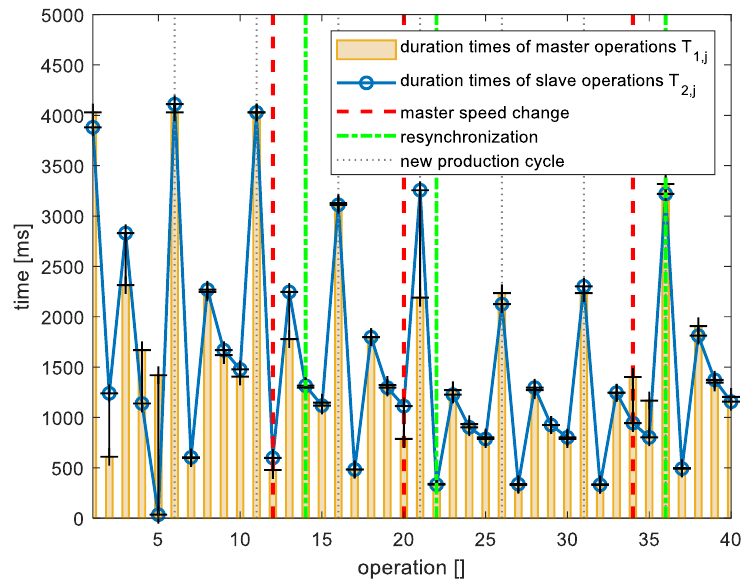
Figure 10. Operation duration times of master and slave manipulators with feedforward synchronization — Experiment 1b.